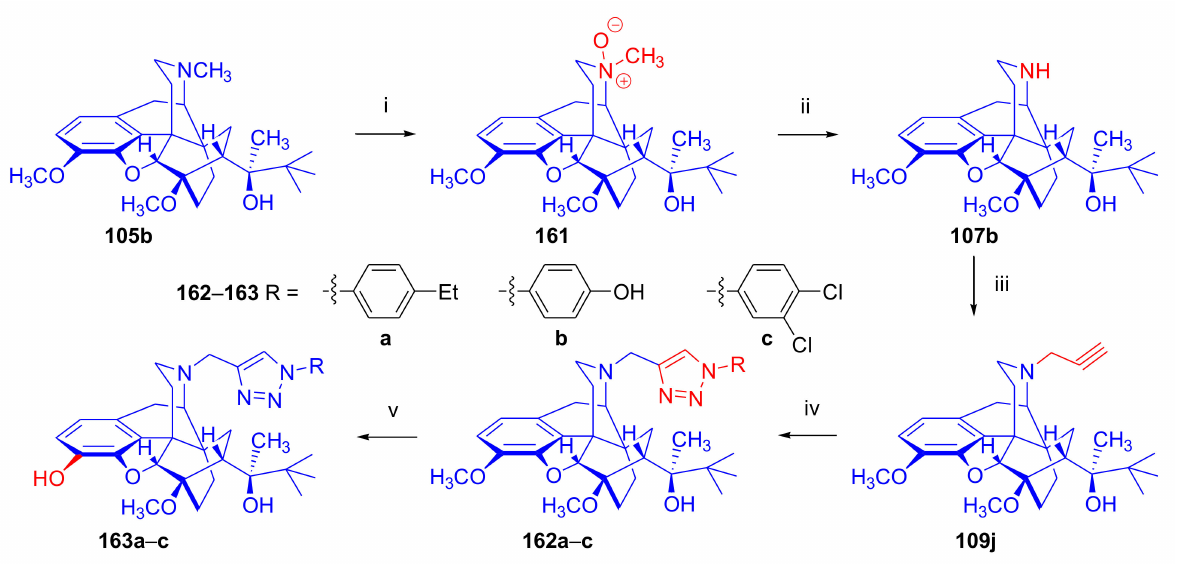
Figure 42. Synthesis of 1,2,3-triazole-tethered N 17 -norbuprenorphine derivatives. Reagents and condi- tions : (i): 33% H 2 O 2 , MeOH; (ii): stainless steel powder, 2-propanol, 50 ◦ C, 8 h, 40%; (iii): 1.2